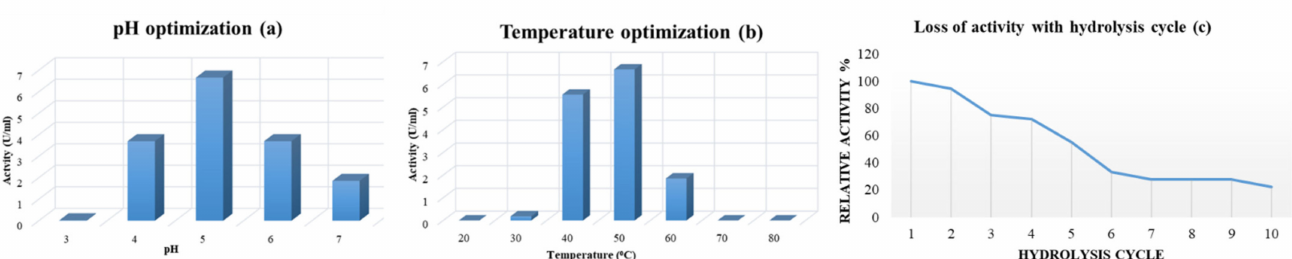
Figure 4. Optimal operating condition study for cellulase immobilized on iron oxide magnetic nanoparticles. ( a ) Optimal pH, ( b ) optimal temperature, ( c ) cellulase activity preservation with each hydrolytic